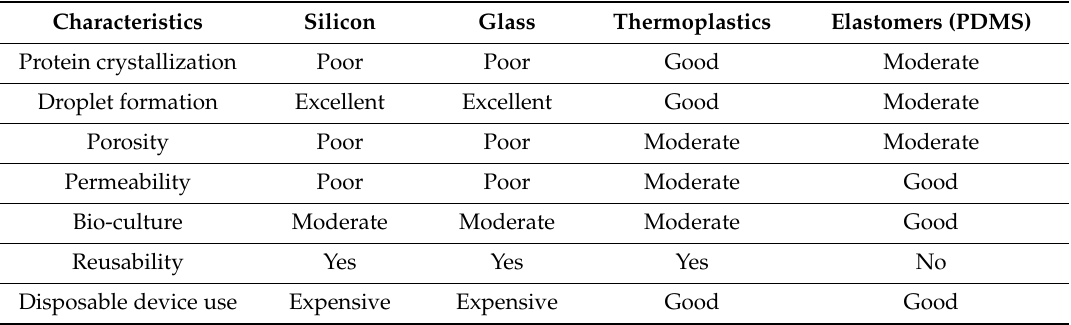
Table 2. Significant characteristics of the most common materials used for biomedical applications. Adapted from [51].